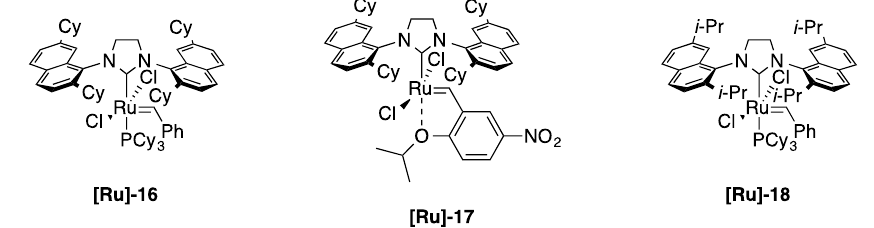
Figure 4. Family of ruthenium complexes bearing N-Heterocyclic Carbene (NHC) ligand with naphthyl side chains used in this